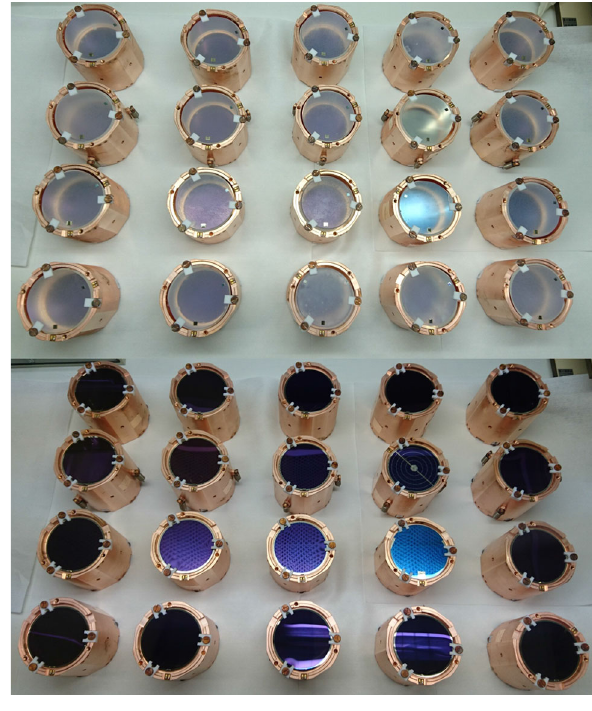
Fig. 5 Twenty CUPID-Mo detector modules before their arrangement in five towers; the devices are shown from the Li 2100 MoO 4 crystal side (top) and from the Ge LD side (bottom)